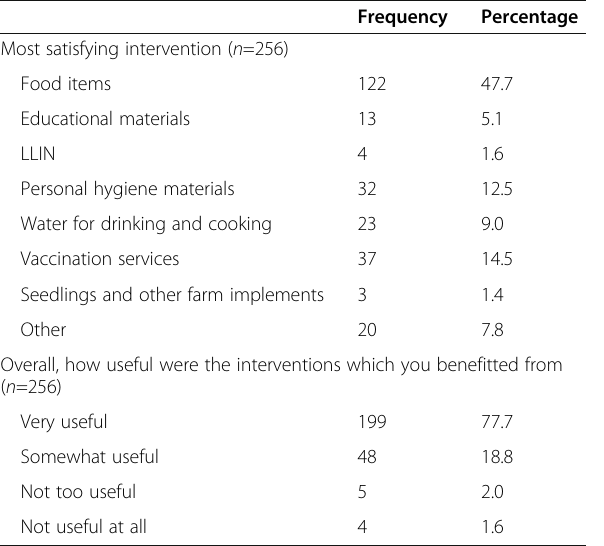
Table 3 Level of satisfaction with the interventions among IDPs in Borno, Nigeria